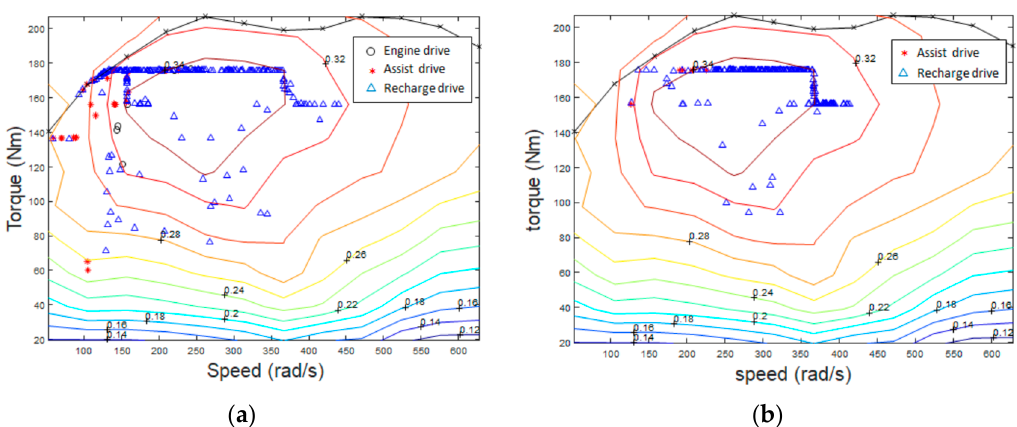
Figure 20. Engine operating point: ( a ) UDDS driving cycle simulation; and ( b ) HWFET driving cycle simulation.